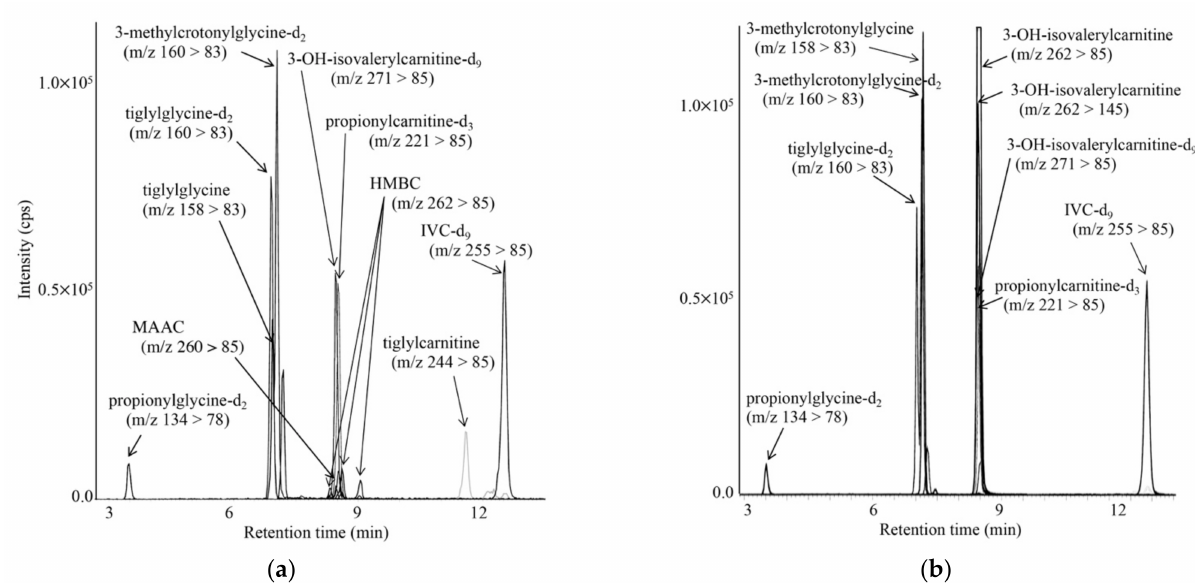
Figure 5. LC-MS/MS analyses for propionylglycine, tiglylglycine, and 3-methylcrotonylglycine, together with acylcarnitines, including tiglylcarnitine, using positive ion mode for a newborn with KTD ( a ) and a newborn with 3MCCD ( b ). The gradient elution program was as follows: 10% B (1 min), 10% to 40% B (4 min), 40% to 59% B (9 min), 55% to 100% B (0.1 min), 100% B (6.9 min), 100% to 10% B (0.1 min), and 10% B (5